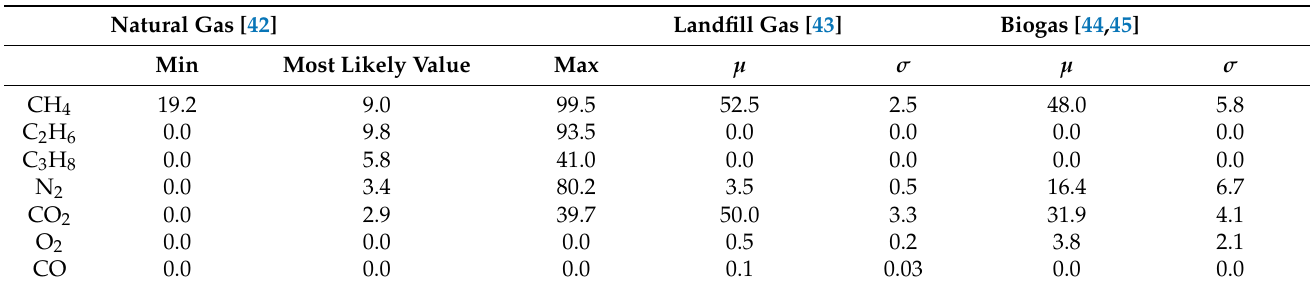
Figure 2. Schematic flowsheet of the simulation. The results reported represent one of the 3000 Monte Carlo cycles performed by the Python code. A complete list of all the simulated results for the three scenarios is available in the Supporting Materials. Table 1. Composition distribution in the mole % for natural gas, landfill gas, and biogas. We assumed a triangular distribution for natural gas and a normal distribution for landfill gas. For each Monte Carlo cycle, Python 3.9.4 initializes the composition of the feedstock according to the probability distribution of each component and then normalizes the values to